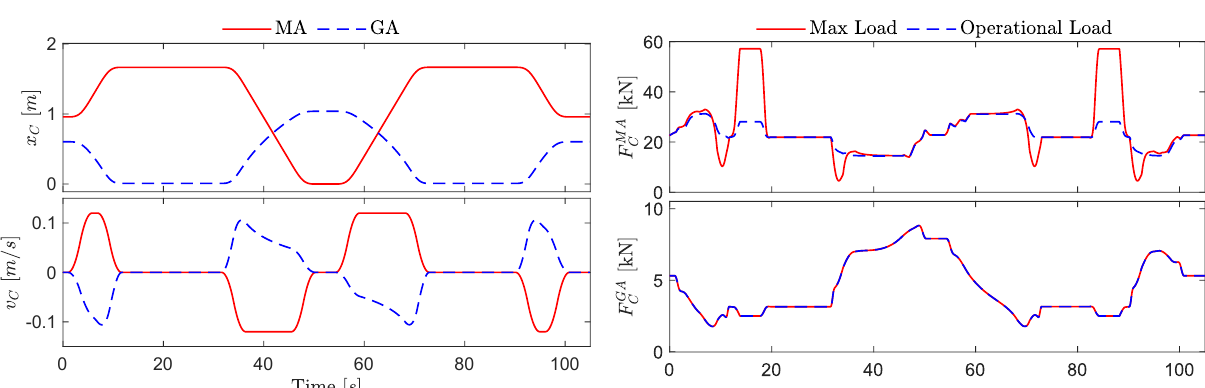
Figure 16: Actuator load cycle at max load and operational load: (top) main arm; (bottom) guide arms.